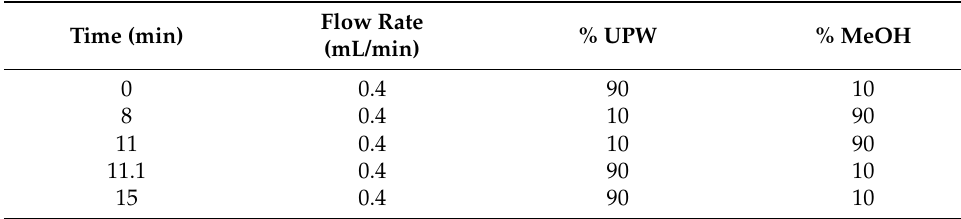
Table 1. Gradient for the mobile phase of